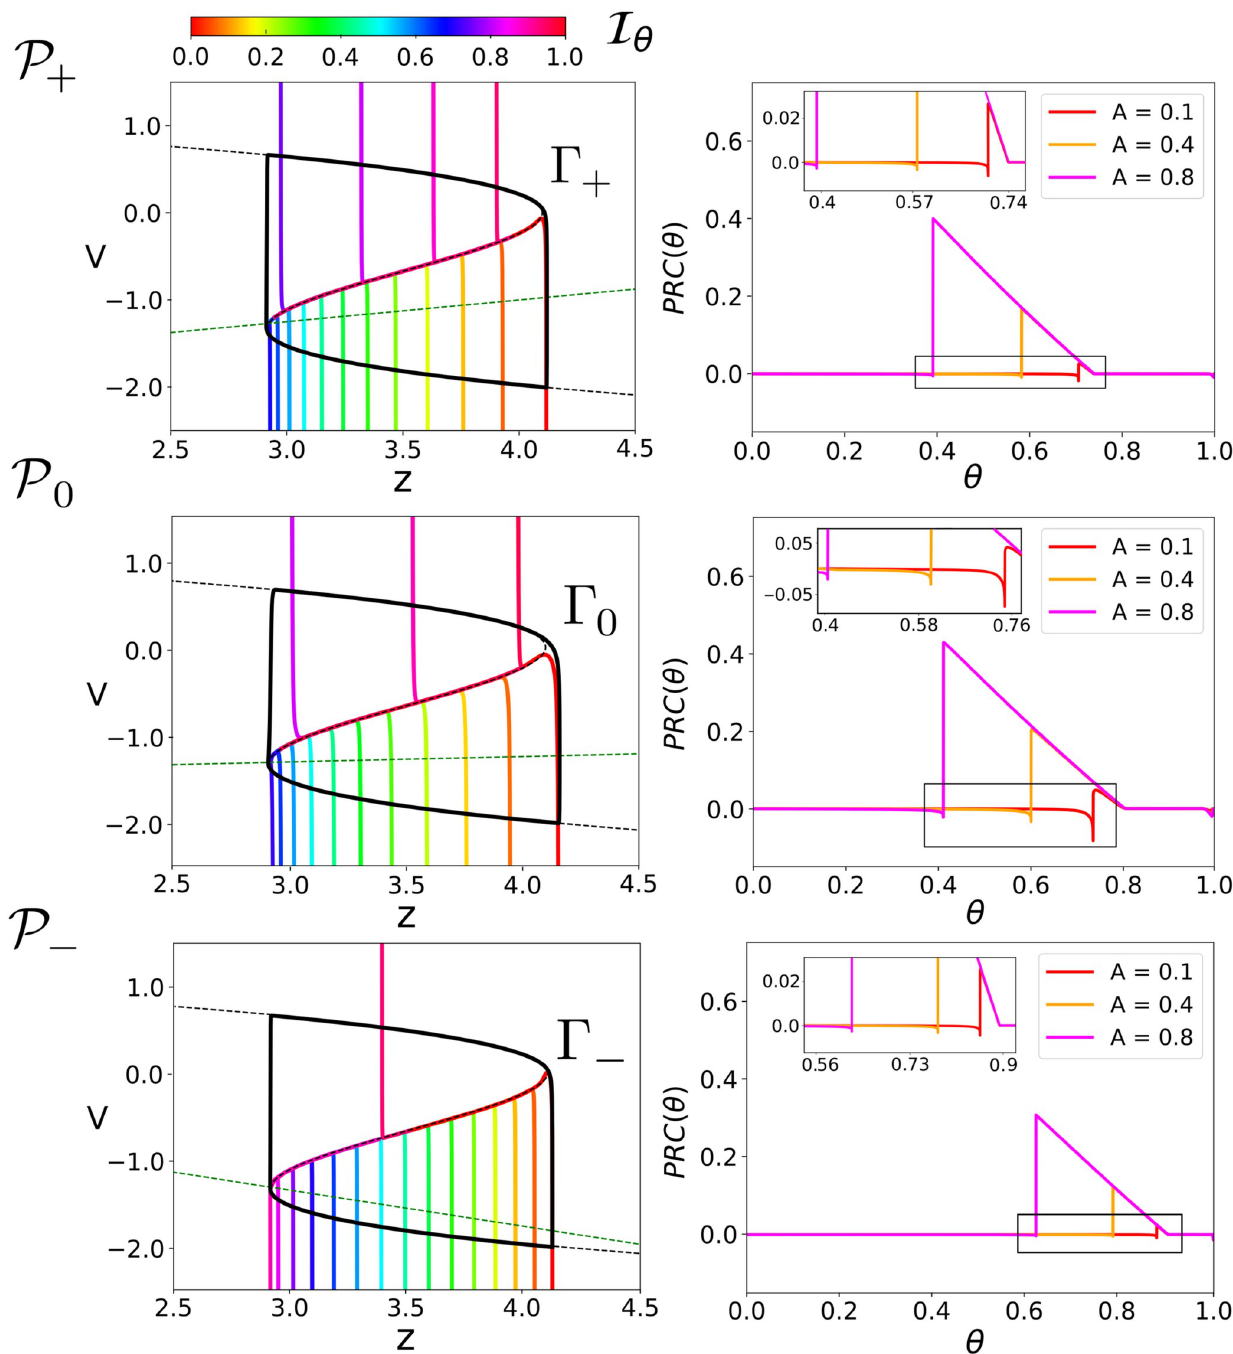
Fig 9. Isochrons and PRCs for the reduced epileptor. For the sets of parameters P isochrons I (left). The phase response curves for pulses in the v direction for different values of A (right). For the three cases we plot 16 equispaced y isochrons. Consistently with our previous analysis, since the monotonicity of the slow vector field does not change, the slope of isochrons does not change sign. For numerical details about the computation of both the isochrons and the PRCs see Materials and methods section.